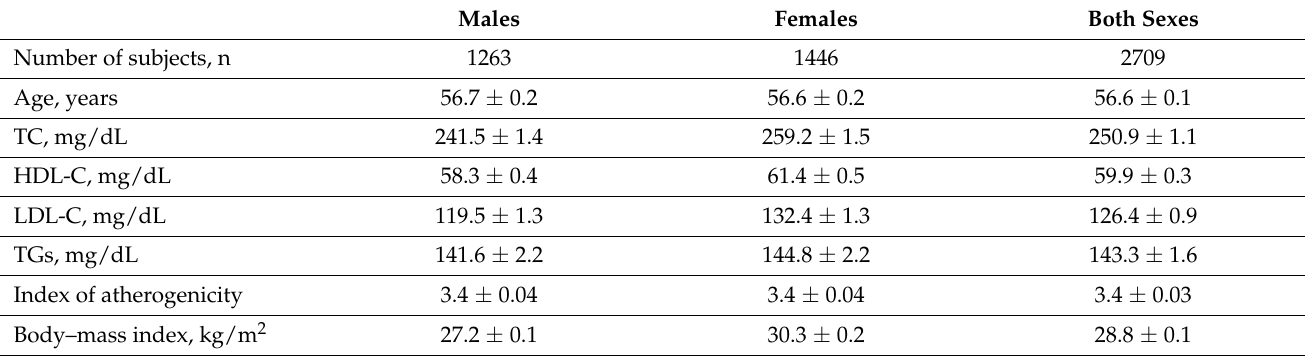
Table 2. Baseline characteristics of the study population ( n = 2709, Western Siberia, Russia) were randomly selected for molecular genetic analysis. Males Females Both